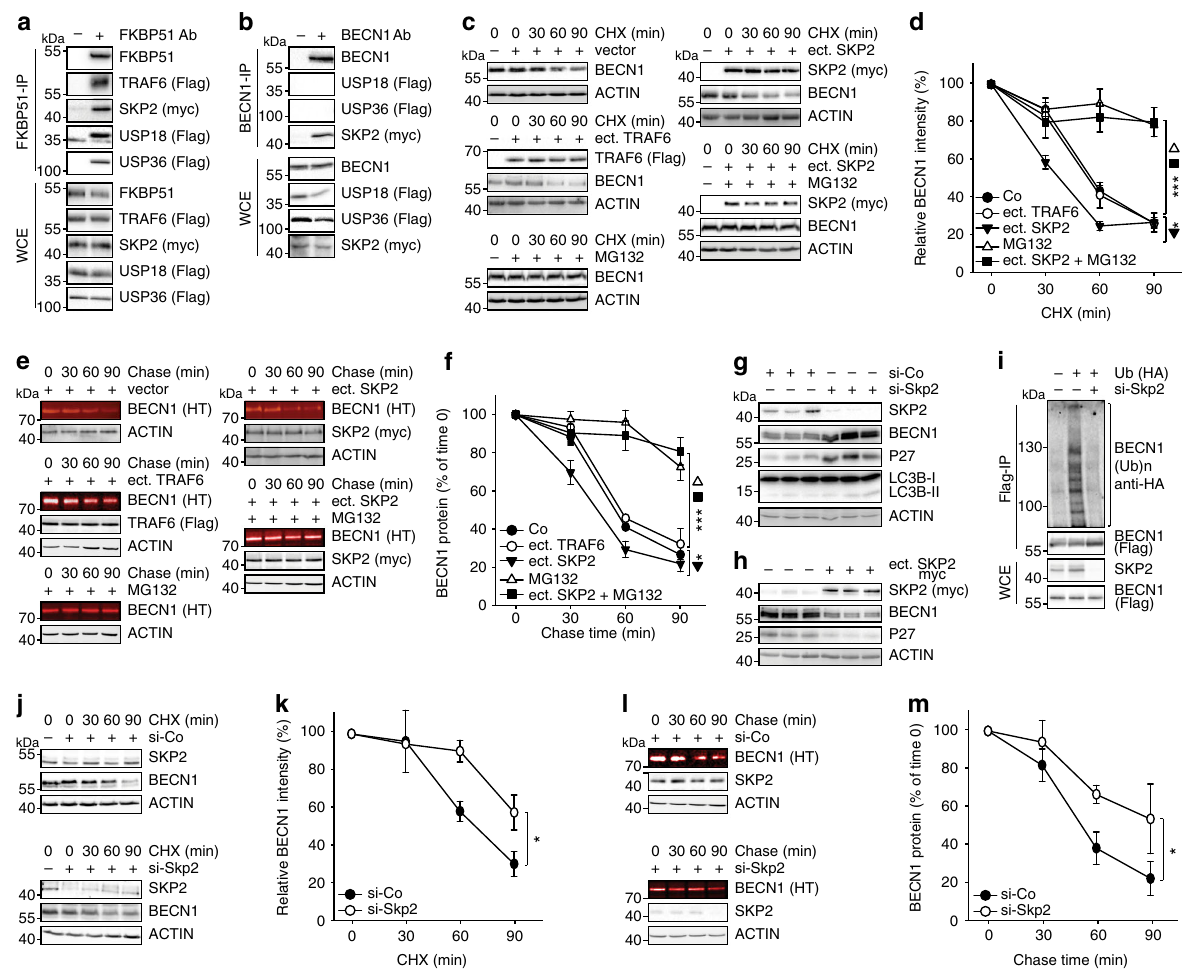
Fig. 2 FKBP51 associates with SKP2 that regulates BECN1 stability. a HEK293 cells were transfected with plasmids expressing the indicated E3 ligases and USPs; after 72 h, cells were either harvested for immunoprecipitation of FKBP51. b BECN1 associates with SKP2, but not with USP18 or USP36. HEK293 cells were transfected with vectors expressing tagged SKP2, USP18 and USP36; after 72 h, cells were harvested for immune-precipitation with either control IgG or anti BECN1 antibody. c , d SKP2 affects BECN1 stability. HEK293 cells were transfected with plasmids expressing SKP2 or TRAF6 and exposed to MG132 (10 µ M, 2 h) where indicated and to cycloheximide (CHX, 30 µ g mL − 1 ) after 72 h for the durations indicated to monitor the decay of BECN1. e , f The conditions of c,d were also used in the pulse-chase assay, performed as in Fig. 1e, f, to determine BECN1 stability. g , h Cellular SKP2 levels determine BECN1 levels. SKP2 was either down-regulated by using siRNA ( g ) or up-regulated by transient transfection ( h ) and the levels of the indicated proteins were measured by western blotting (P27 served as control). Quanti fi cations for g and h are provided in Supplementary Fig. 1c, d. i Knock-down of SKP2 by siRNA decreases BECN1 ubiquitination (assay as in Fig. 1b). j – m Stability assays were performed like in c – f to determine the effect of SKP2- targeting siRNA on BECN1 stability. WCE = whole cell extract. In all panels, error bars denote the standard error of the mean, derived from n = 3 biologically independent experiments. * p < 0.05, ** p < 0.01, *** p < 0.001 (two-way ANOVAs, details in Supplementary Table 1). Source data and blot collections are provided as a Source Data fi